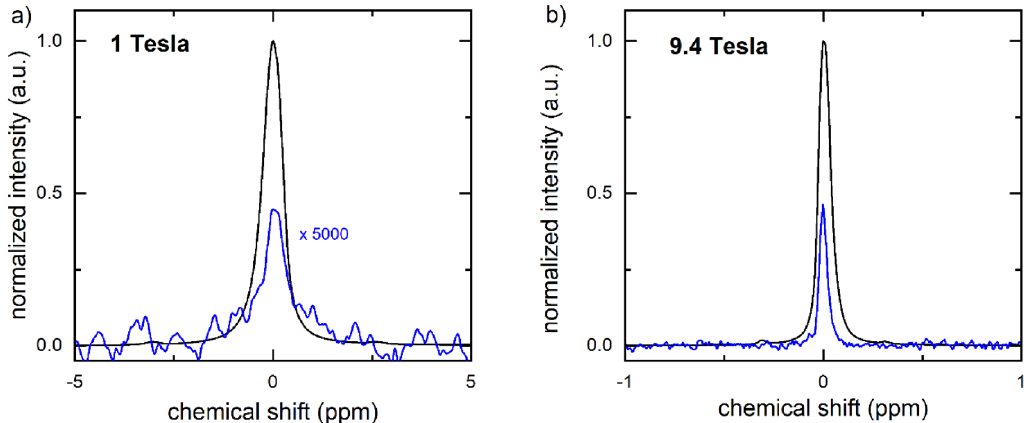
Figure 6. High resolution 13 C-NMR spectra of hyperpolarized (black) thermally polarized (blue) 1- 13 C-PA measured at 1 T ( a ) and 9.4 T ( b ). ( a ) The hyperpolarized signal was measured in a single scan (NS DNP = 1) after approx. 26 s after dissolution ( α = 5°, p w = 3.05 µs, p a = − 5.6 dB, S DNP = 32.38 a.u.). The thermally polarized signal was acquired adding 4 vol% Gd contrast agent ( α = 20°, p w = 12.20 µs, p a = − 5.6 dB, S DNP = 4.18 × 10 −4 a.u.). The resulting signal enhancement to S DNP was 1.09 × 10 9 (Eq. 8), and the polarization = 26% (Eqs. 9, 10). ( b ) At 9.4 T, the signal was acquired ≈ 30 s after dissolution using a 5° pulse (S DNP = 7.59 × 10 5 a.u., p w = 10 µs, p a = − 18.9 dB, RG = 0.25) and quantified with respect to the thermally polarized signal acquired with a single 90° pulse (S TP = 1.41 × 10 5 a.u., p w = 0.55 µs, p a = − 18.9 dB, RG = 101) to an enhancement of 2.5 × 10 4 (Eq. 8) and polarization of 20% (Eqs. 9, 10). Note that due to the differences in the RG, both hyperpolarized spectra were normalized to 1 and the thermal spectrum measured at 1 T was multiplied by 5000 to fit in the scale.